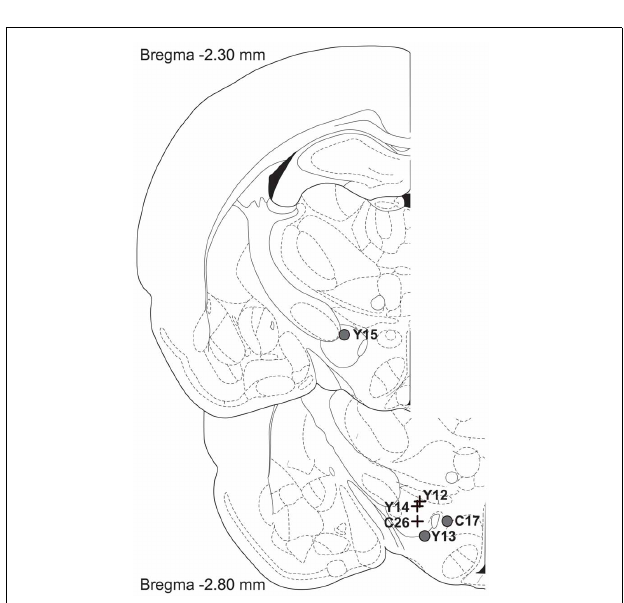
FIGURE 9 | Summary of the shifts in the position of the reward-mountain produced by increasing the train duration from 0.25 to 1s. Increasing the train duration reduced the pulse frequency required to produce a half-maximal reward in all rats (upper panel). In contrast, there was no change, in three cases, in the price at which time allocation for a maximal reward fell halfway between TA max and TA min , whereas lengthening the train duration reliably increased the value of this position parameter in the remaining three rats (lower panel). ∗ Indicates that the 95% confidence interval does not include zero.